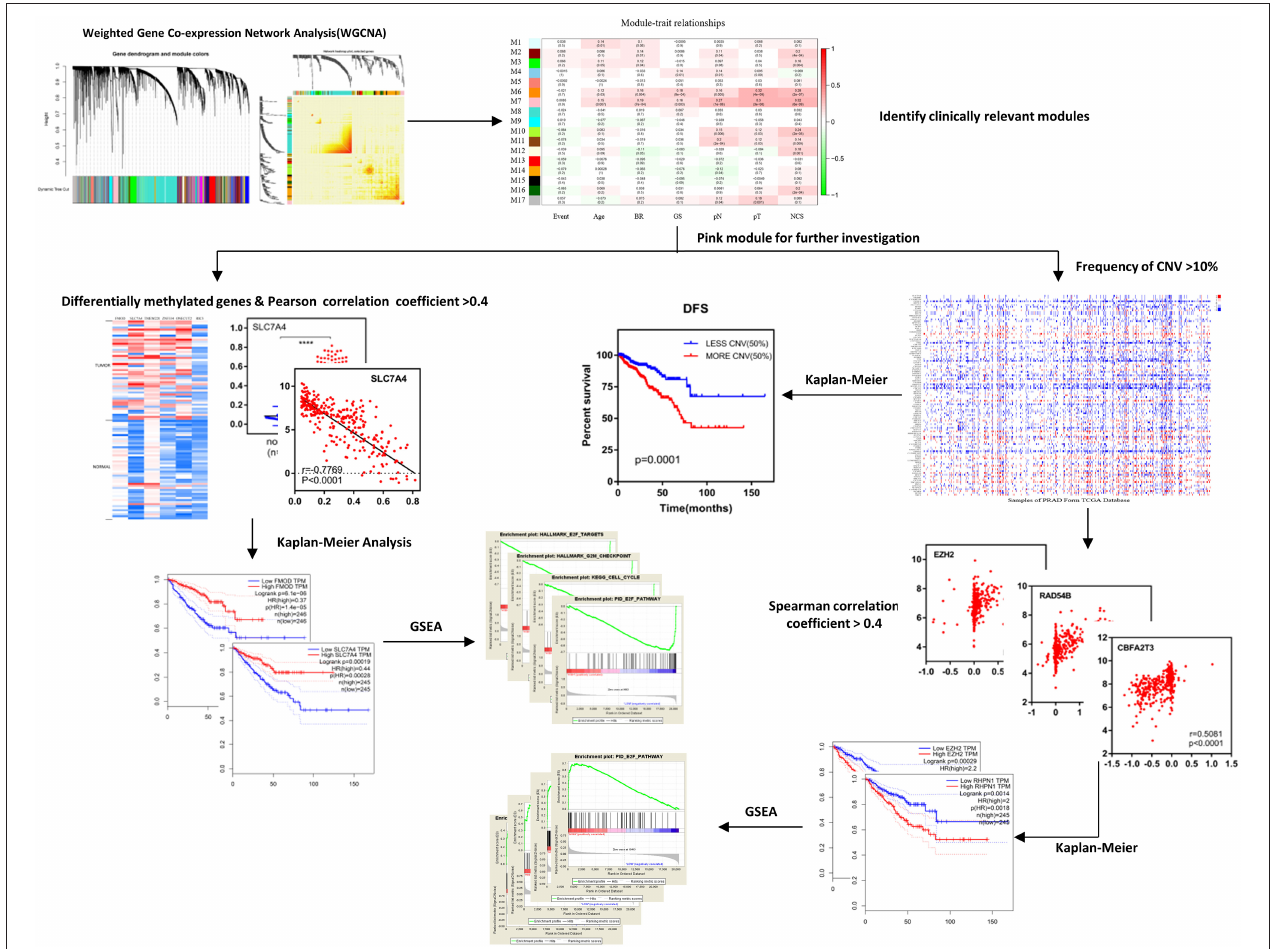
FIGURE 1 | Schematic diagram of the study. After identifying clinically relevant modules with WGCNA, the pink module (M7) was selected for further investigation including differentially methylated genes and frequency of CNVs, afterwards, the Kaplan–Meier survival analysis, and GSEA were used to obtain results and conclusions. WGCNA, weighted gene co-expression network analysis; DFS, disease-free survival; CNV, copy number variation; GSEA, Gene Set Enrichment